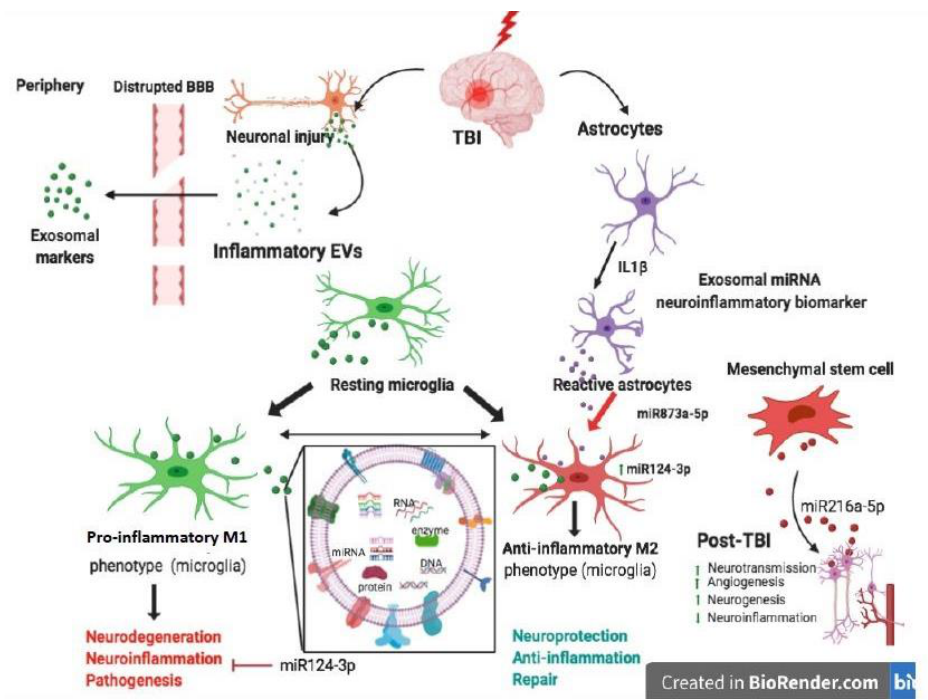
Figure 2. Schematic representation of the e ff ects of EVs in Traumatic Brain